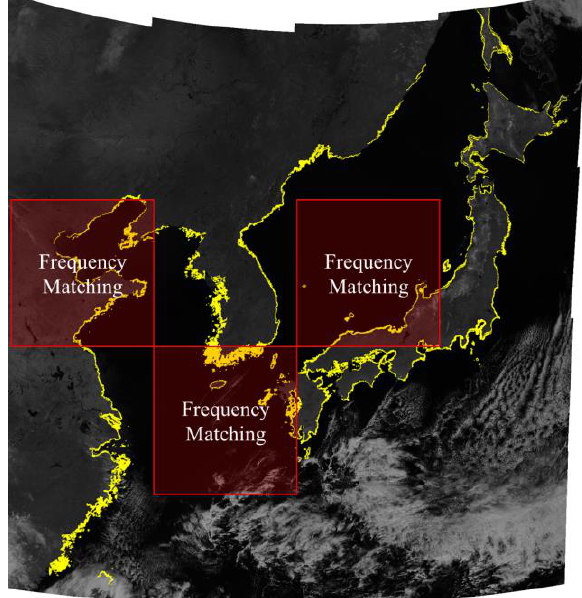
Figure 11 . The result of second experiment